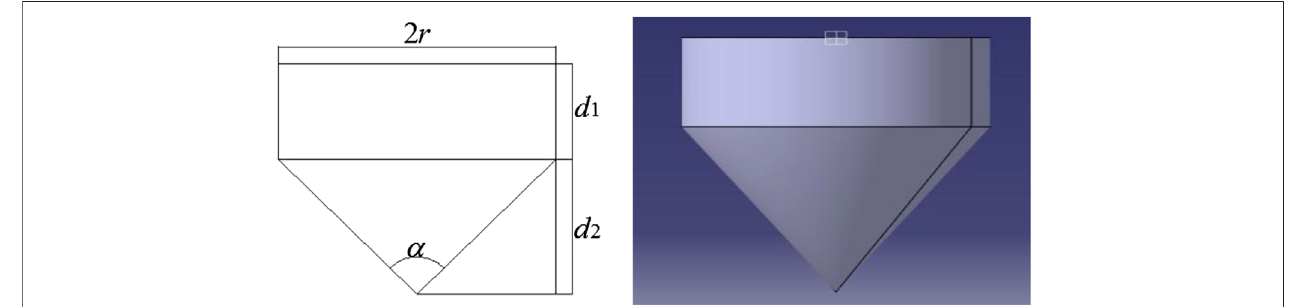
Figure 3 | Schematic diagram of the submerged part of the conical-bottom cylindrical WEC.